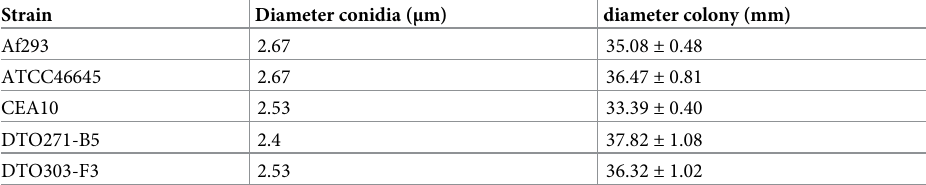
Table 2. Highest frequency of the diameter ( μ m) of conidia (S1 Fig) and average diameter of colony (mm) ( ± SE) after 2 days of growth (Fig 1).